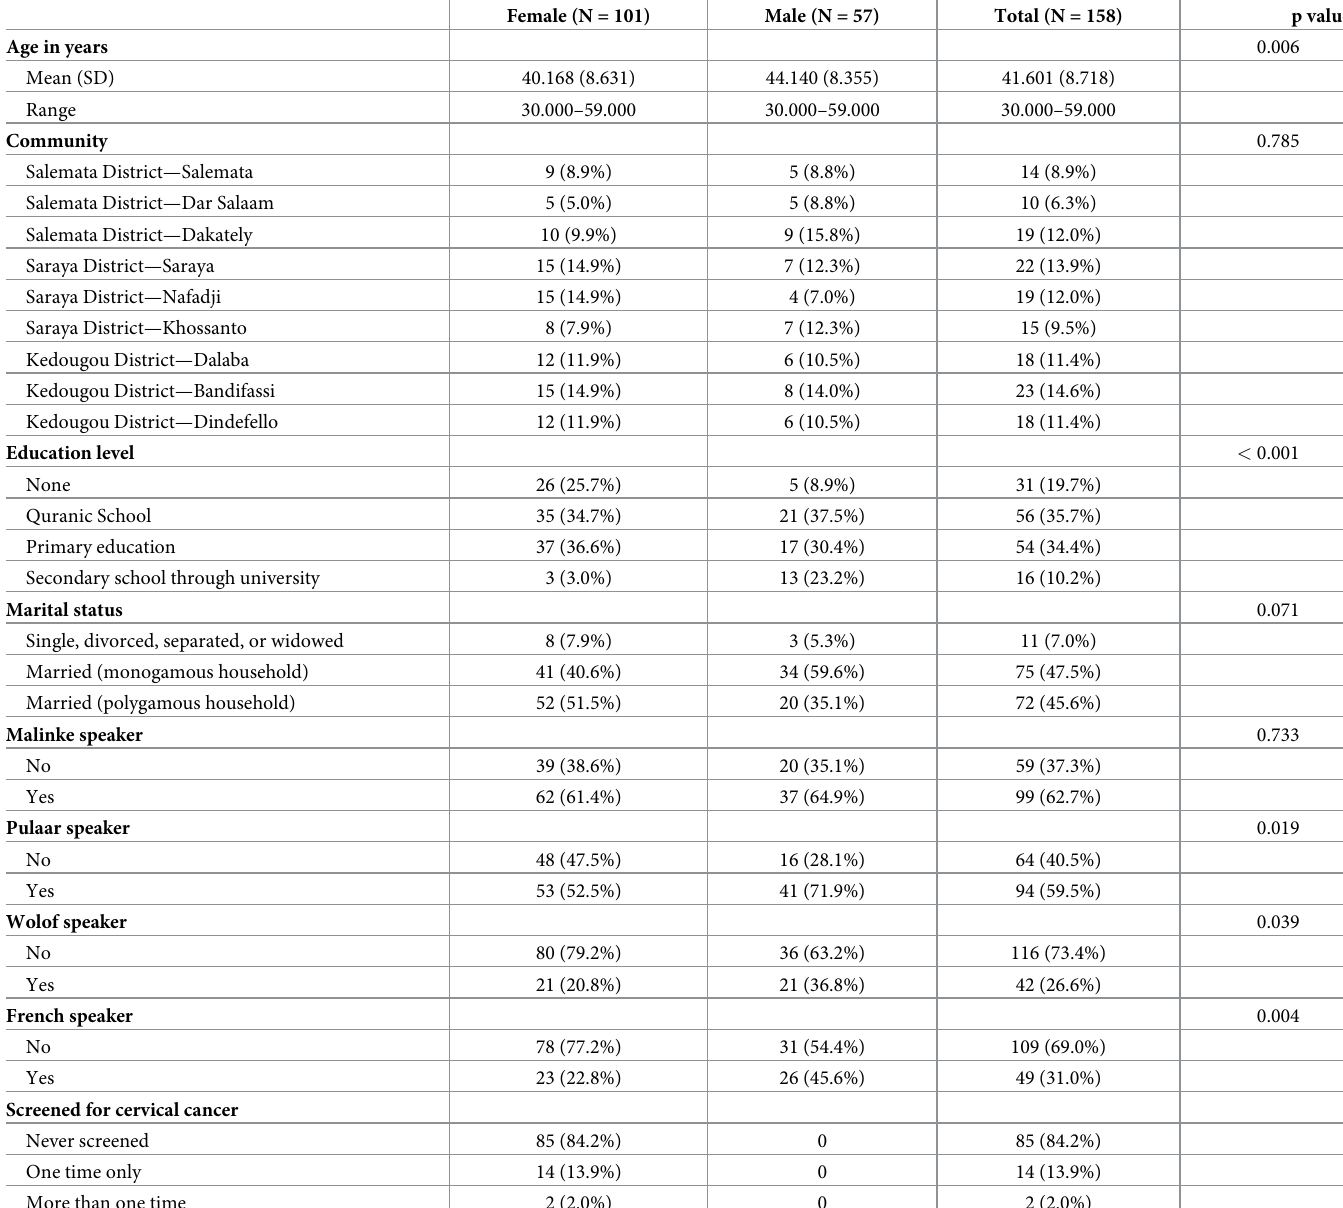
Table 1. Demographics by